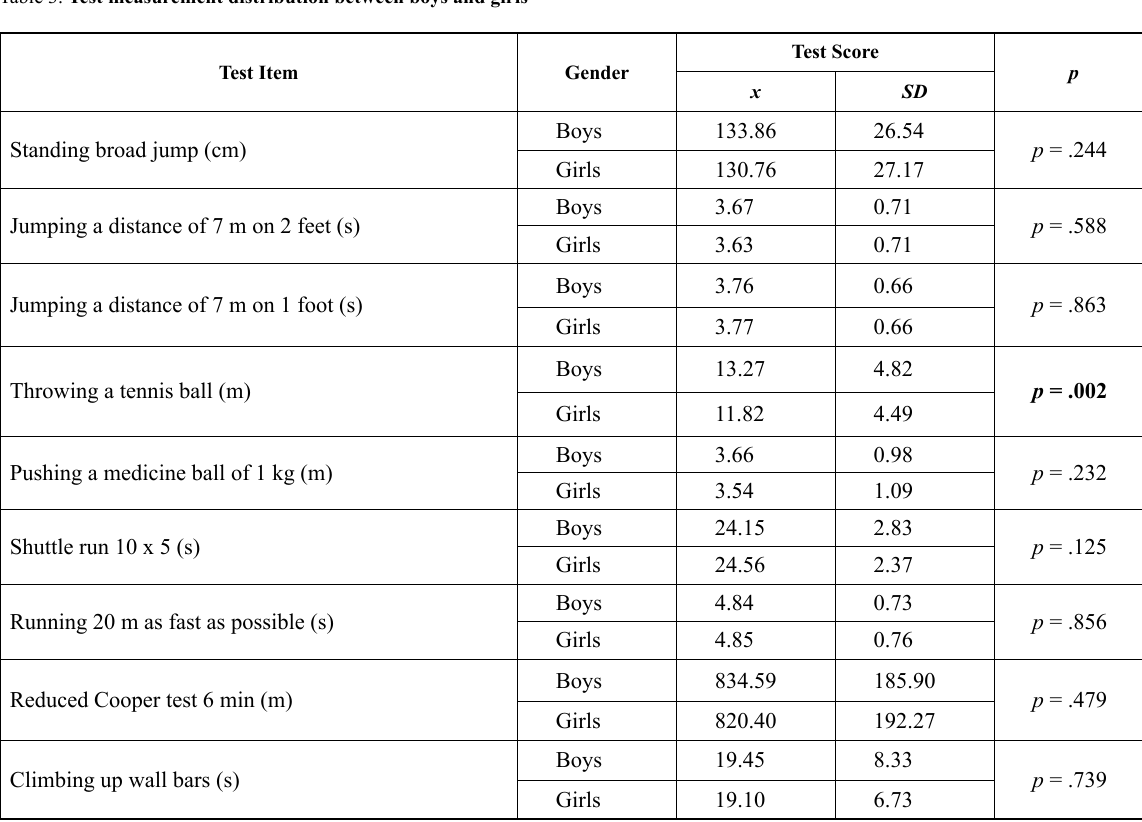
Table 4. Pearson correlation coefficients for total test score and individual tests items